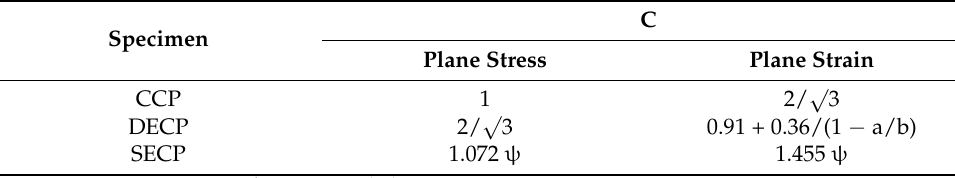
Table 2. Limit load parameters for the specimens